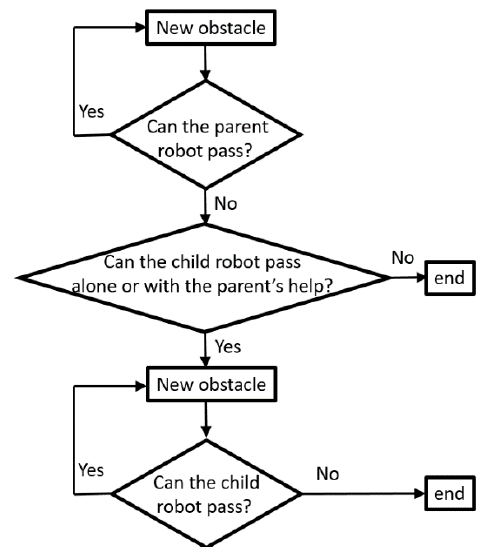
Figure 13. Flowchart of the obstacles that the collaborating parent and child robots can overcome.